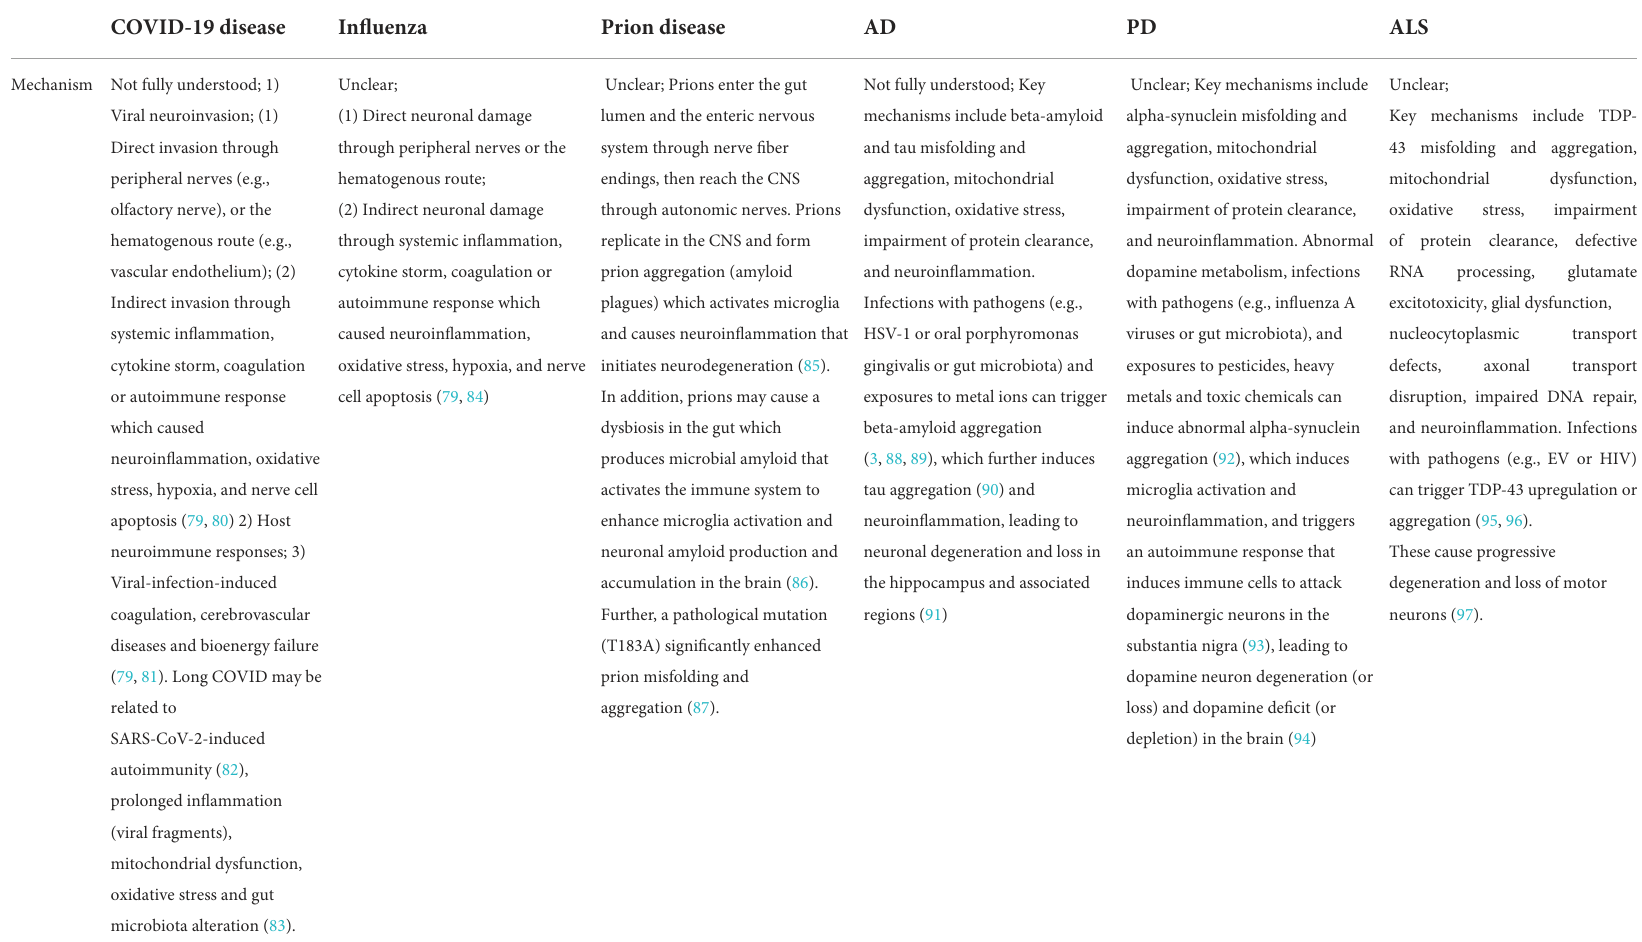
TABLE 5 Mechanisms and treatments of neorlogical injury in the infectious diseases (COVID-19, influenza and prion disease), and the neurodegenerative disorders (Alzheimer’s Disease, Parkinson’s Disease, and Amyotrophic Lateral Sclerosis). COVID-19 disease Influenza Prion disease